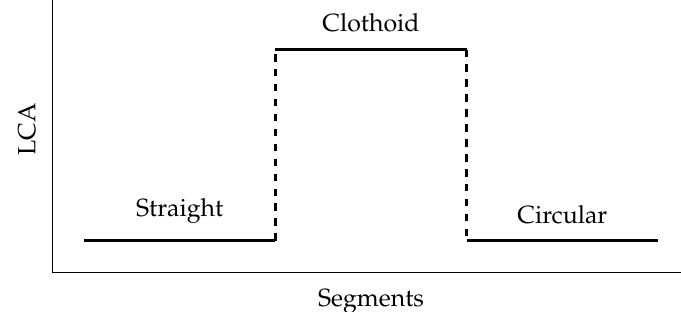
Figure 3. Lateral change of acceleration (LCA) plot of a clothoid connected to a straight and circular